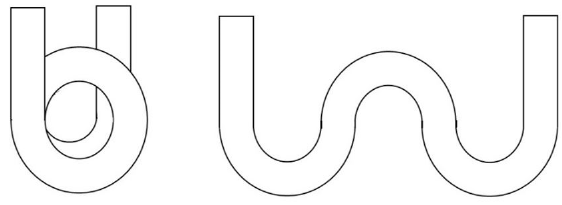
Figure 11. Coil-shaped and a meander-shaped probe models used for simulation.